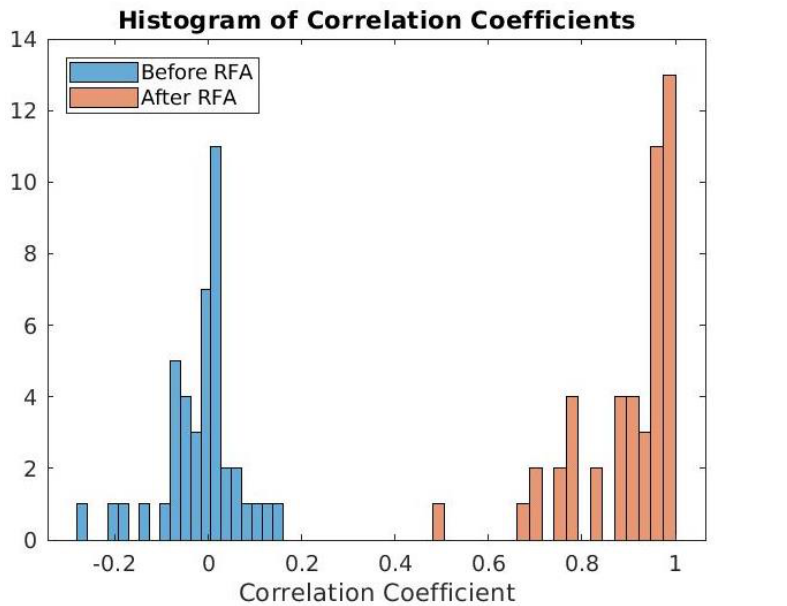
Figure 5. Correlation coefficient histogram collected from real-world audio recordings before and after applying the robust filtering